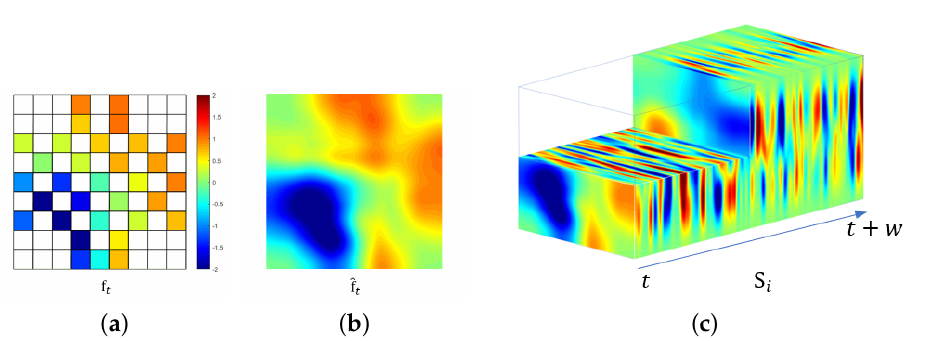
Figure 5. Illustration of spatio-temporal conversion. ( a ) 2D representation of 1D raw EEG data at time t . (Empty values are represented as white.); ( b ) 2D EEG frame ˆ f t from sparse f t by interpolation; ( c ) 3D EEG stream S i with the length w . (Note that the front dashed part is intentionally expressed to show the middle row of the 3D EEG